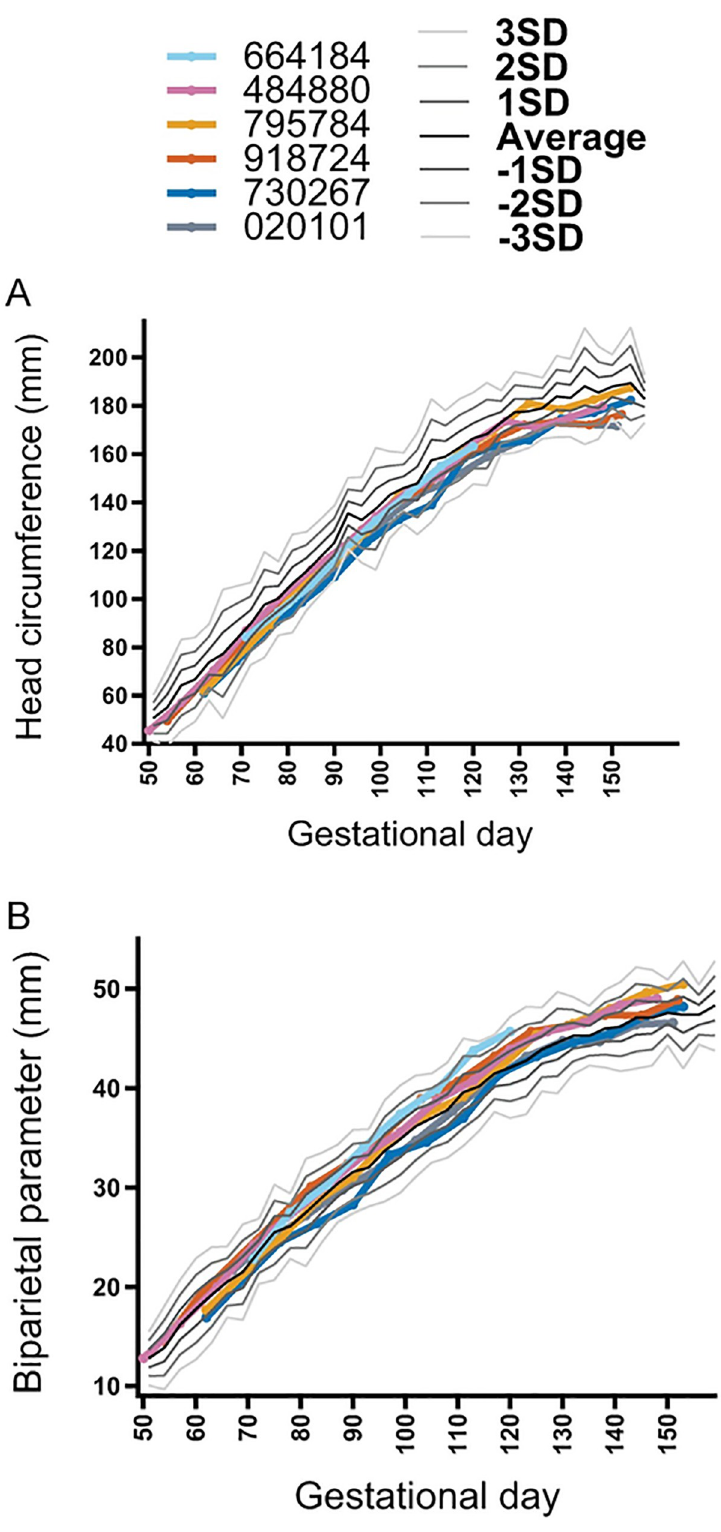
Fig 3. Fetal head growth during pregnancy. Fetal ultrasonography depicting head circumference (A) and biparietal diameter (B) during gestation. The growth curve standard deviation (SD) was calculated from normative fetal rhesus macaque measurements